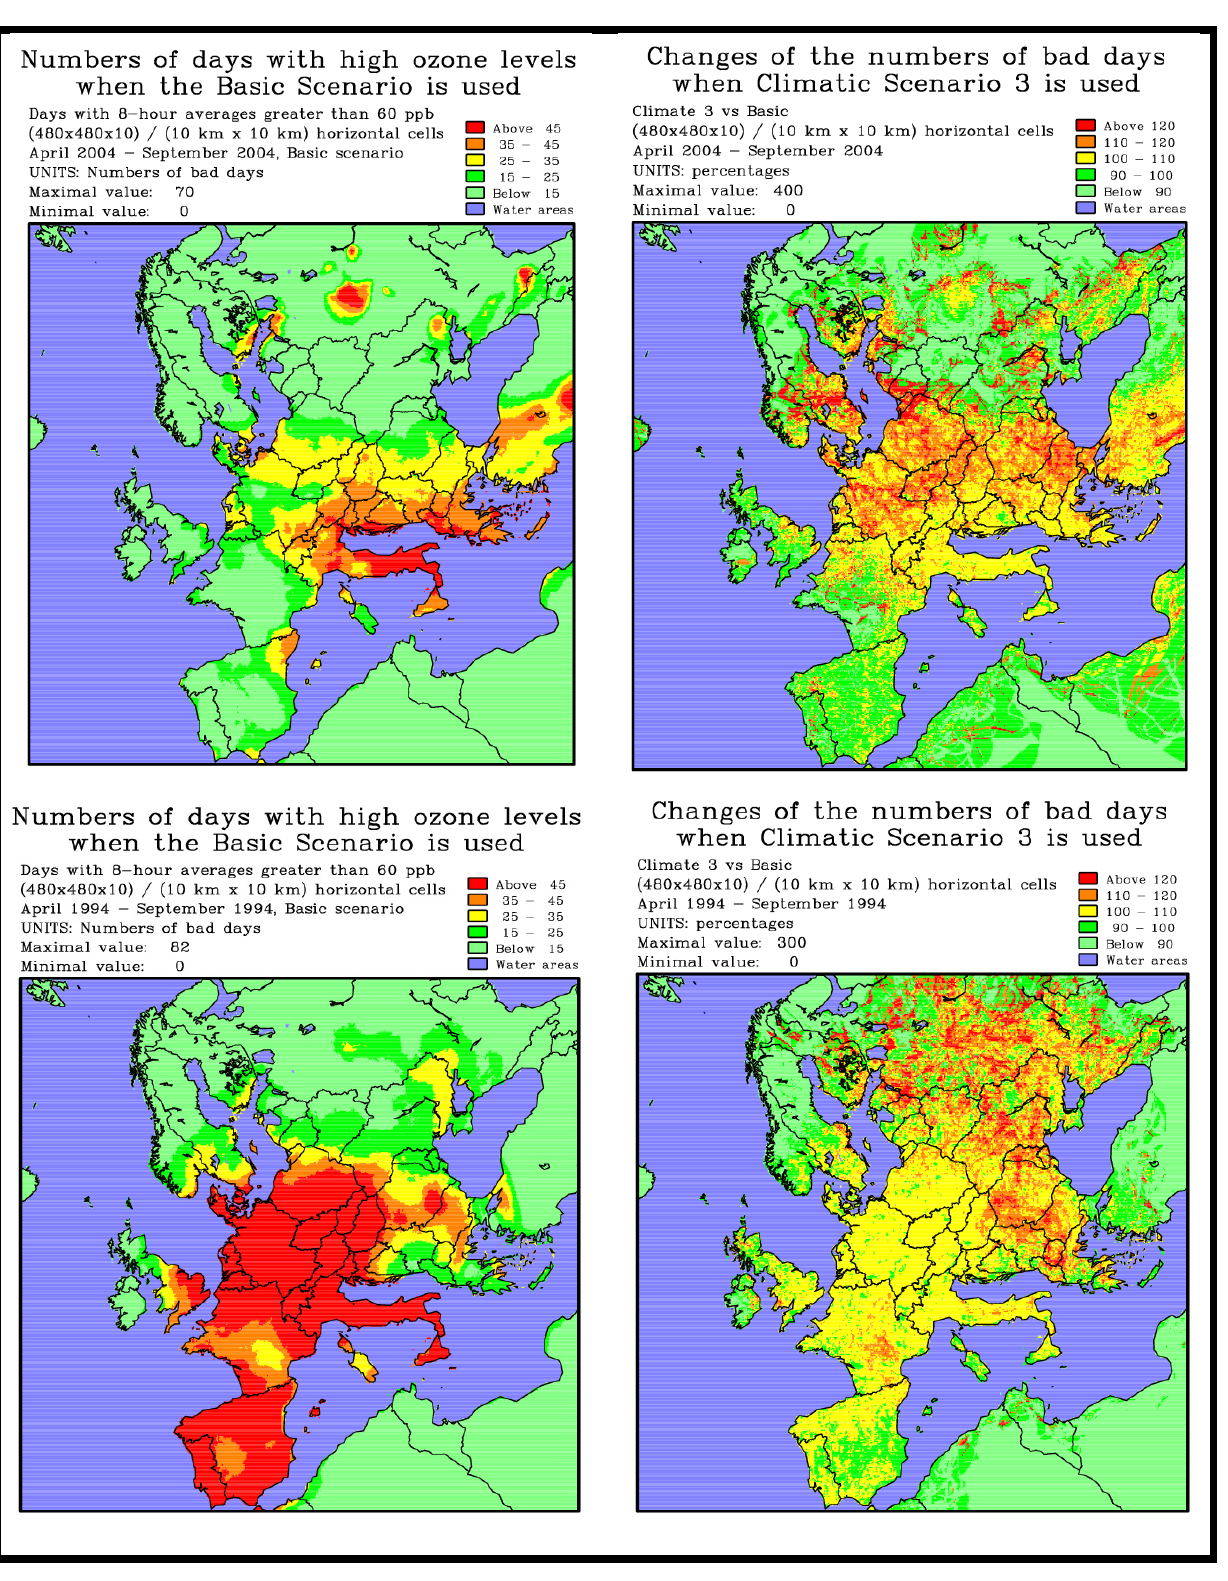
Figure 3. Numbers of “bad days” in year 2004 (the upper left-hand-side plot) and in year 1994 (the lower left-hand-side plot). The corresponding increases (in percent) of the “bad days” when the Third Climatic Scenario is used are given in the two right-hand-side plots.